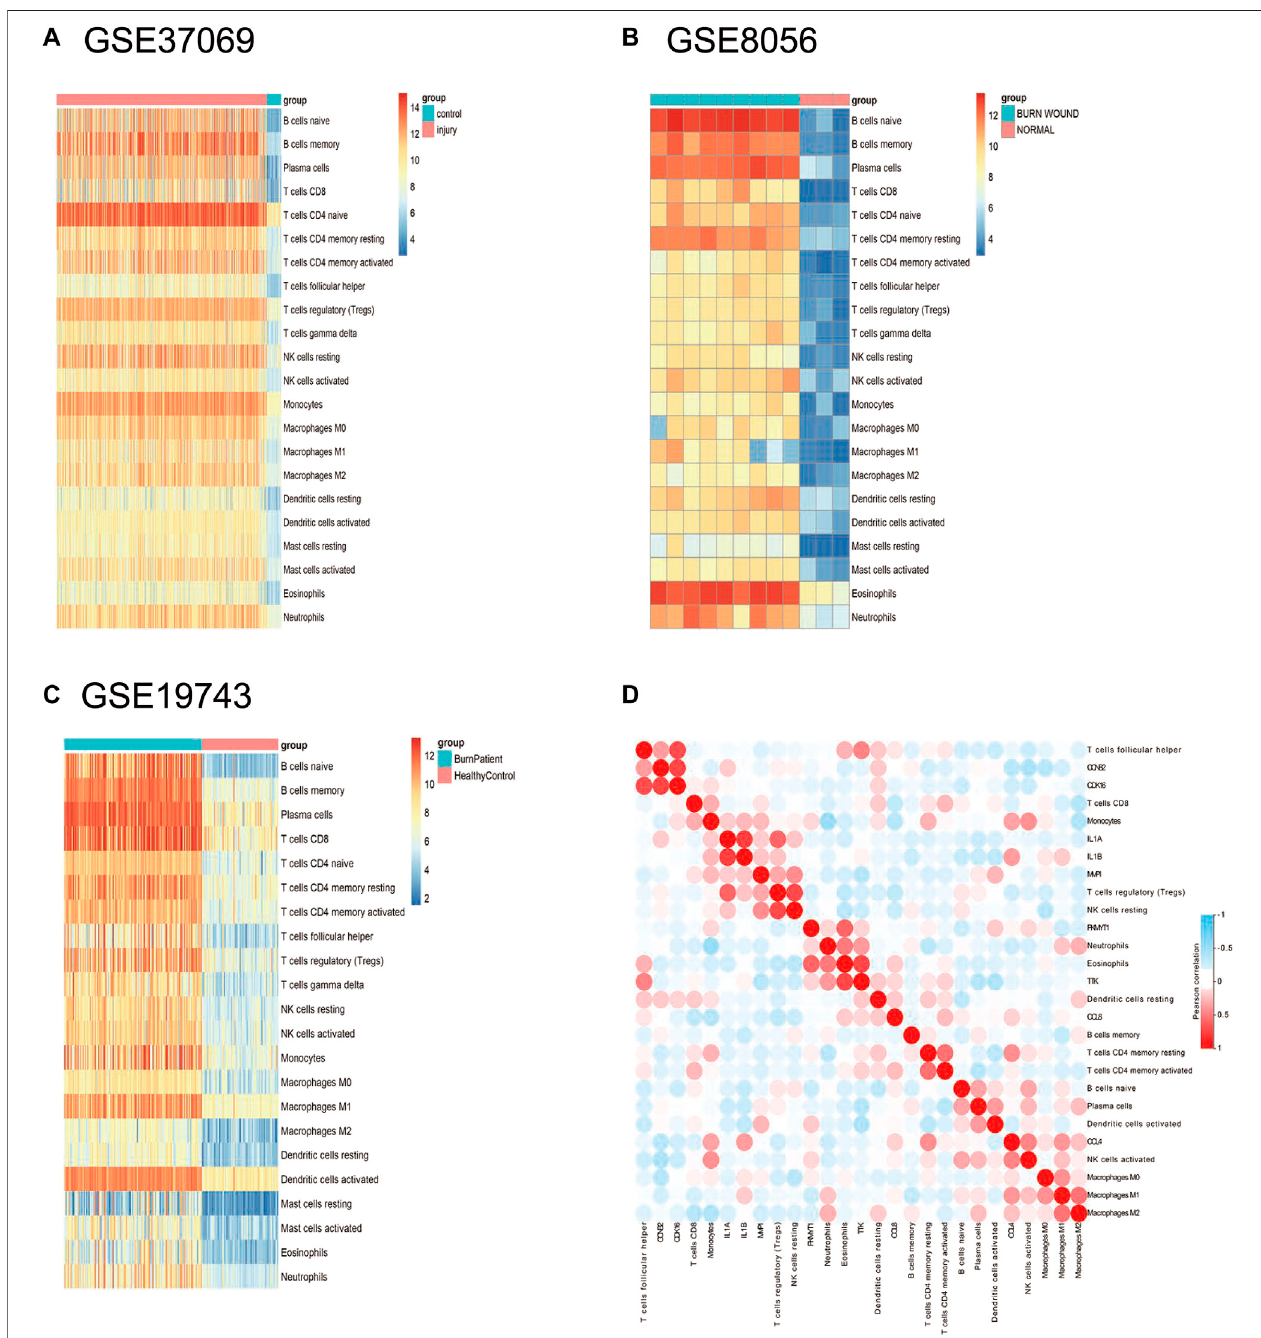
FIGURE 9 | Immune in fi ltration analysis in the three datasets. (A) The expression heatmap of 22 immune cells in GSE37069; (B) the expression heatmap of 22 immune cells in GSE8056; (C) the expression heatmap of 22 immune cells in GSE19743; (D) correlation heatmap of immune cells in burn injury.